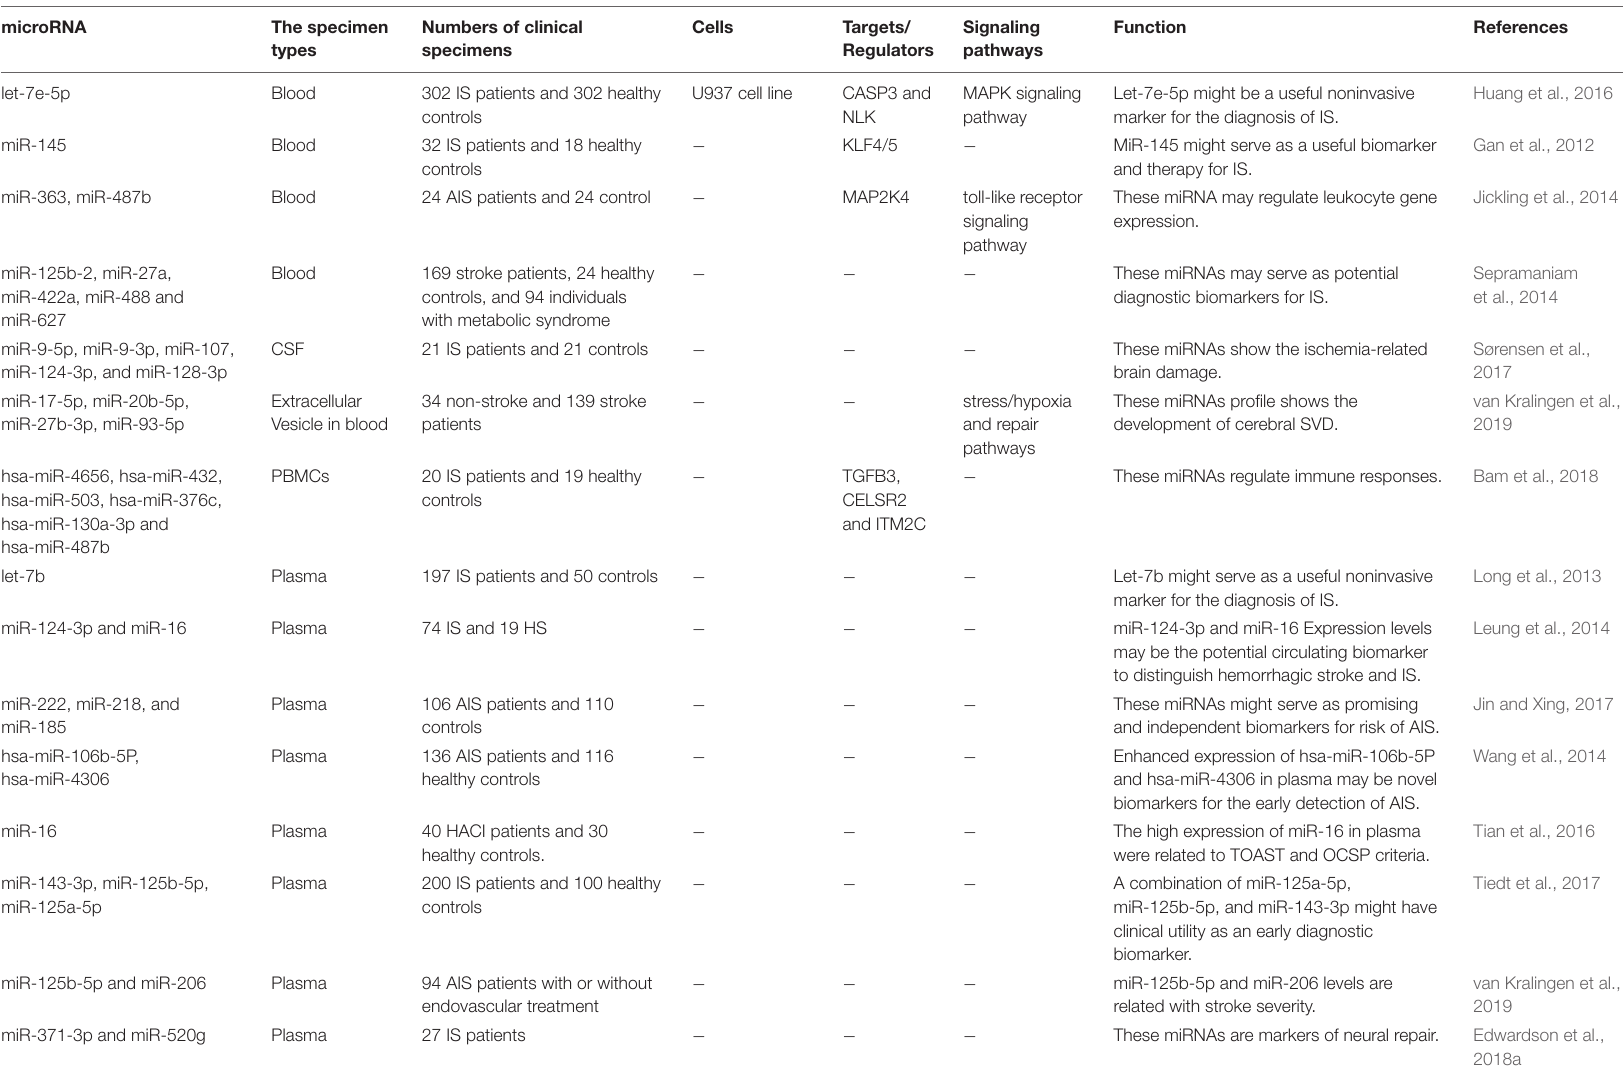
TABLE 4 | Summary of human studies reporting elevation of miRNAs in IS.